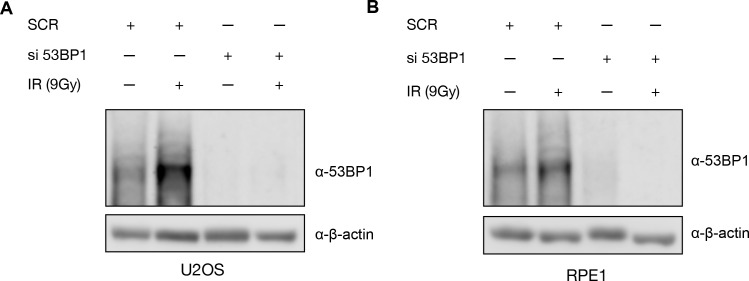
Validation of 53BP1 siRNA western blots demonstrating depletion of 53BP1 protein in U2OS and RPE1 cells treated with siRNA targeted to 53BP1.